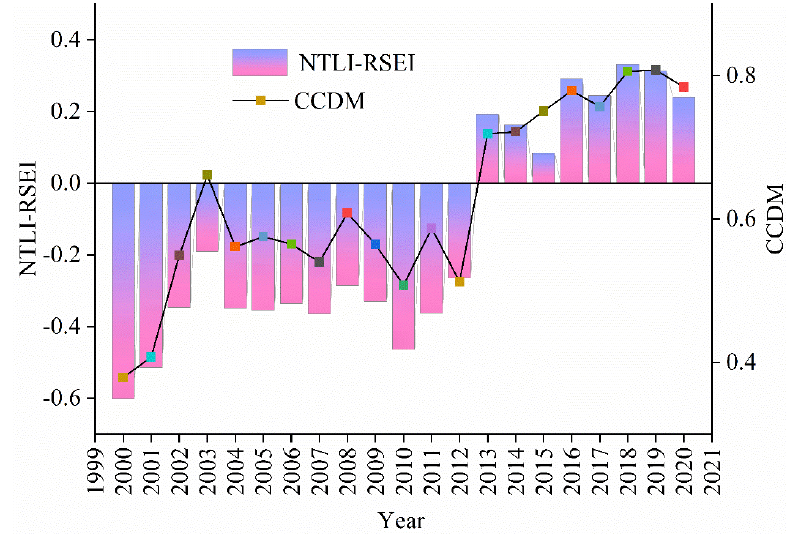
Figure 8. Finer division results between CCDM, NTLI, and RSEI.